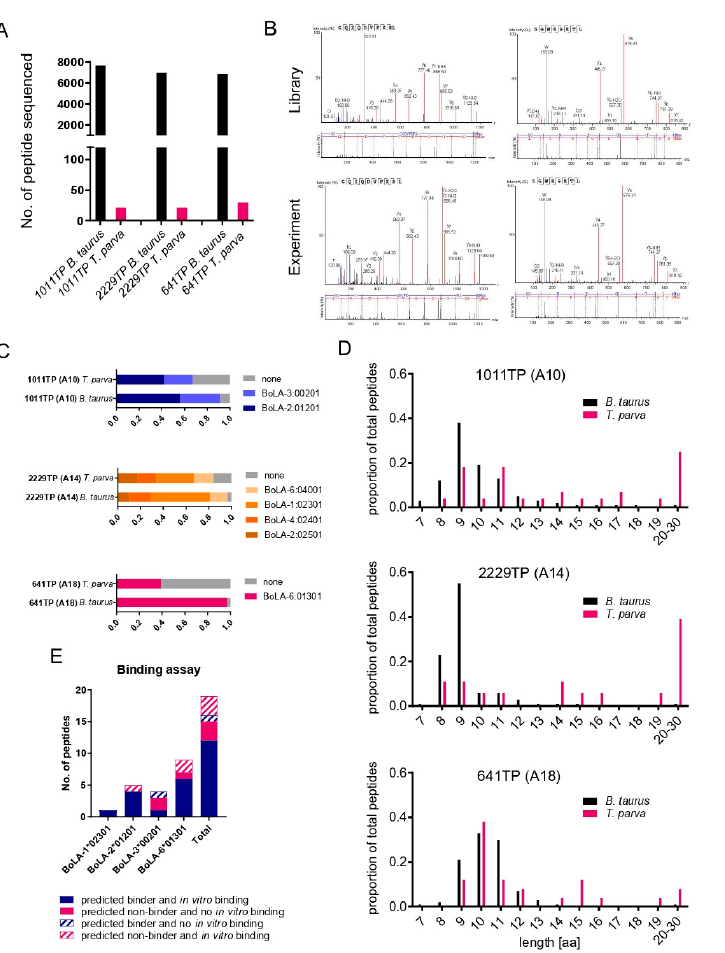
Figure 1. Characteristics of BoLA-I-eluted peptides from 1011TP, 2229TP, and 641TP cell lines. ( A ) Number of B. taurus and T. parva peptide sequences identified in each sample. ( B ) Spectra obtained from the experiment (bottom), and synthetic library (top), respectively, for two example peptides that were mapped to the T. parva proteome. The most abundant, annotated b- (N-terminal) and y- (C-terminal) fragment ions are indicated together with the measured mass over charge ratio. ( C ) Binding predictions of B. taurus and T. parva 8 – 12 mer peptides stratified by their predicted BoLA-I allele of origin (peptides with a rank predicted binding score of <2% to a BoLA-I allele were considered to be binders). Peptides predicted to be MHC-binders are represented by coloured blocks, peptides predicted to be non-MHC binders are represented by grey blocks; the size of the blocks is proportional to the number of peptides in the respective datasets. ( D ) Length distributions of B. taurus and T. parva peptides were identified in each sample. The horizontal axis shows the length of peptides, and the vertical axis shows the proportion of the peptides identified for each length. ( E ) A summary of results from a subset of peptides assayed in an in vitro BoLA-I binding assay is presented in Table 2. For each BoLA allele and for all of the BoLA alleles combined (Total), the number of peptides for which the in vitro assay corroborated the in silico predicted capacity to bind to BoLA-I are shown as filled bars, whilst peptides for which the results from the in vitro binding did not support the in silico prediction are shown as hatched bars, as described in the legend.